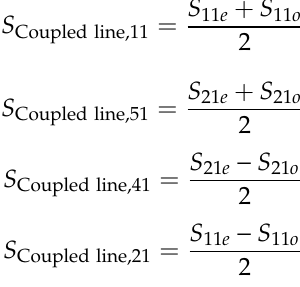
Figure 2. Equivalent circuit of the proposed balun for signal flow analysis.